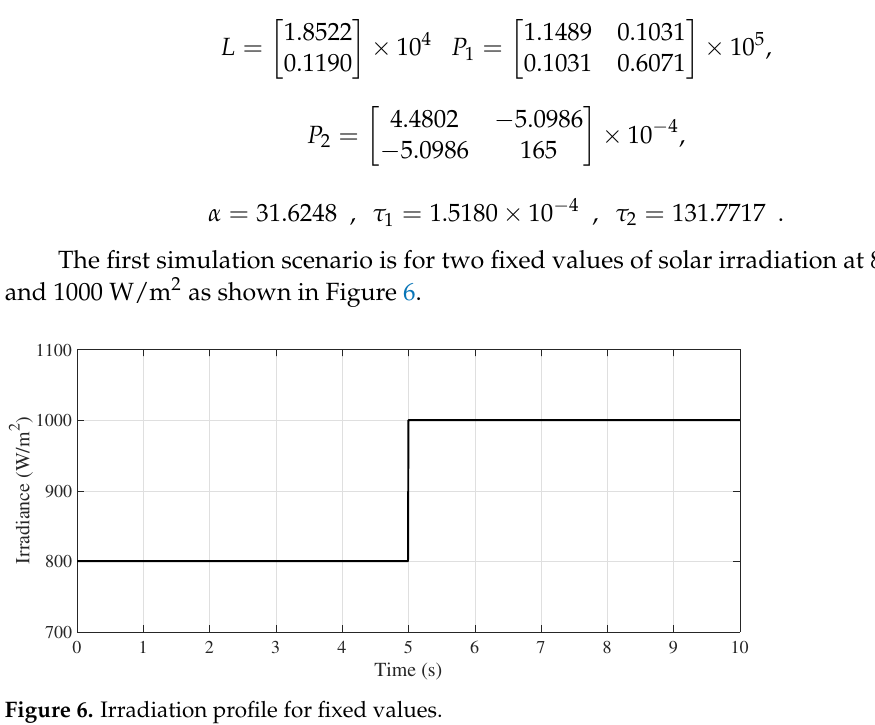
Figure 5. I-V curve for PV module 1Soltech 1STH-240-WH. The proposed observer gain matrix L and ellipsoid size matrix P obtained by solving the optimization problem (30) with a parameter uncertainty equal to 10% of the nominal component value (for R , L b , C b ) are